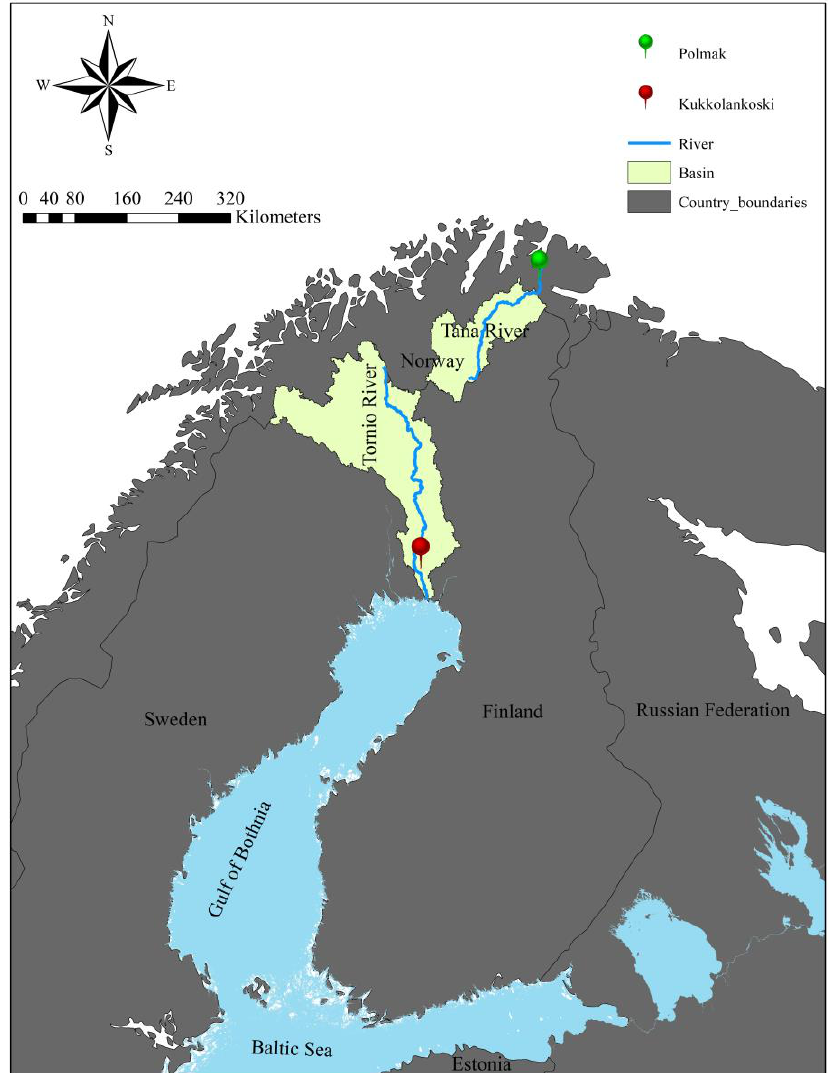
Figure 1. The study area, the Tana and Tornio Rivers located at the Finnish border with Norway and Sweden. The river gauges used in the study are Polmak (green) and Kukkolankoski (red).